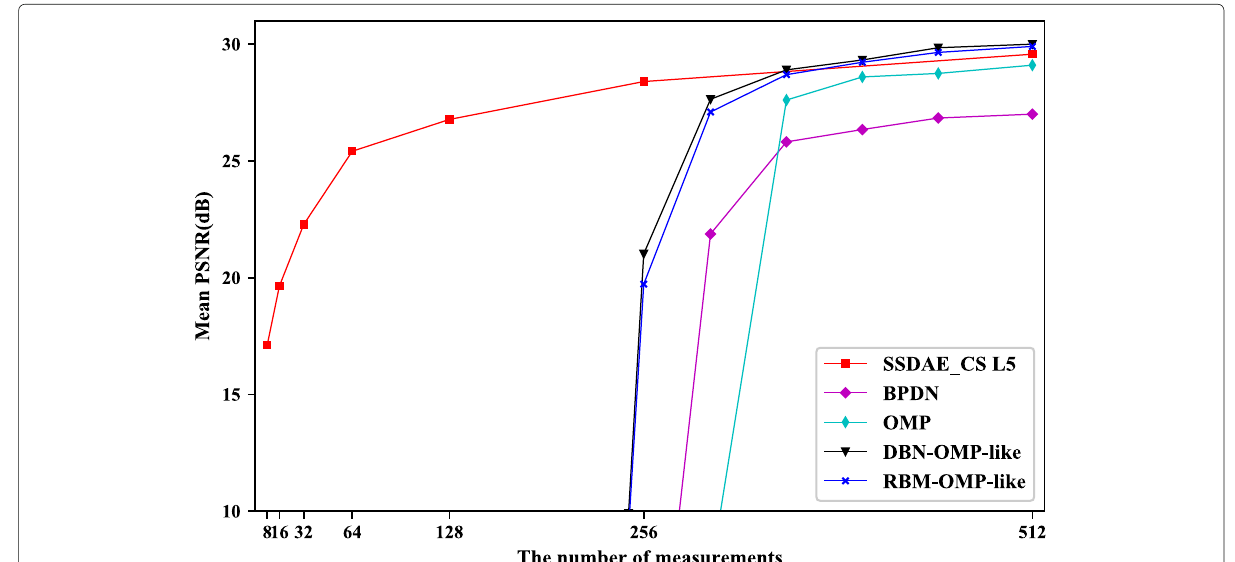
Fig. 5 Evaluation of the reconstruction performance of the MNIST dataset in different reconstruction